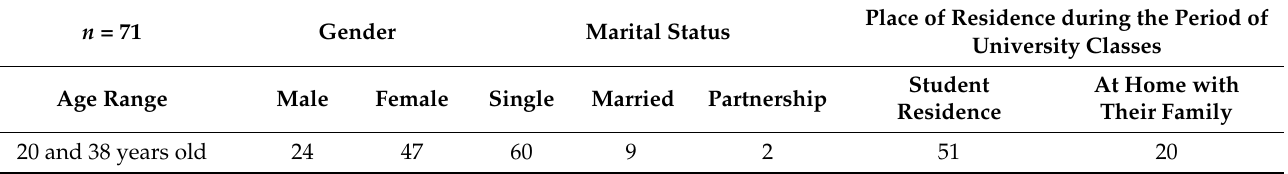
Table 1. Socio-demographic characteristics of participants ( n = 71).